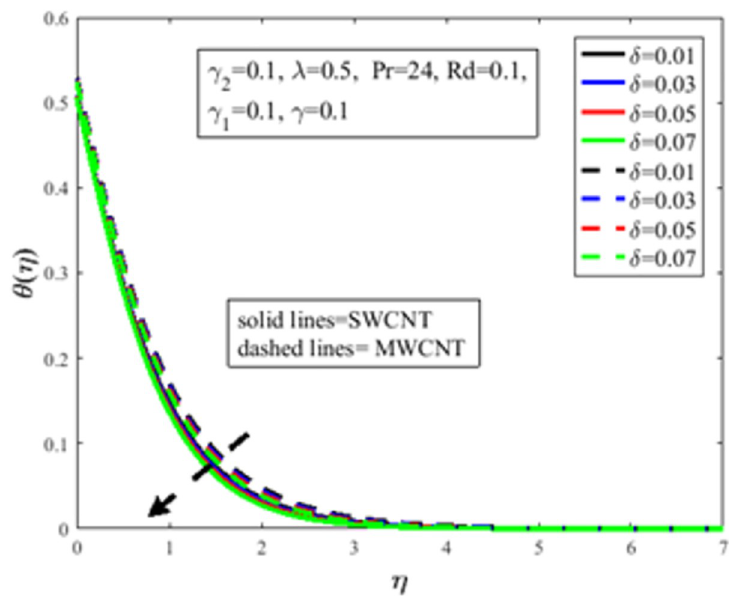
Fig 13. Effect of δ on θ ( η ).